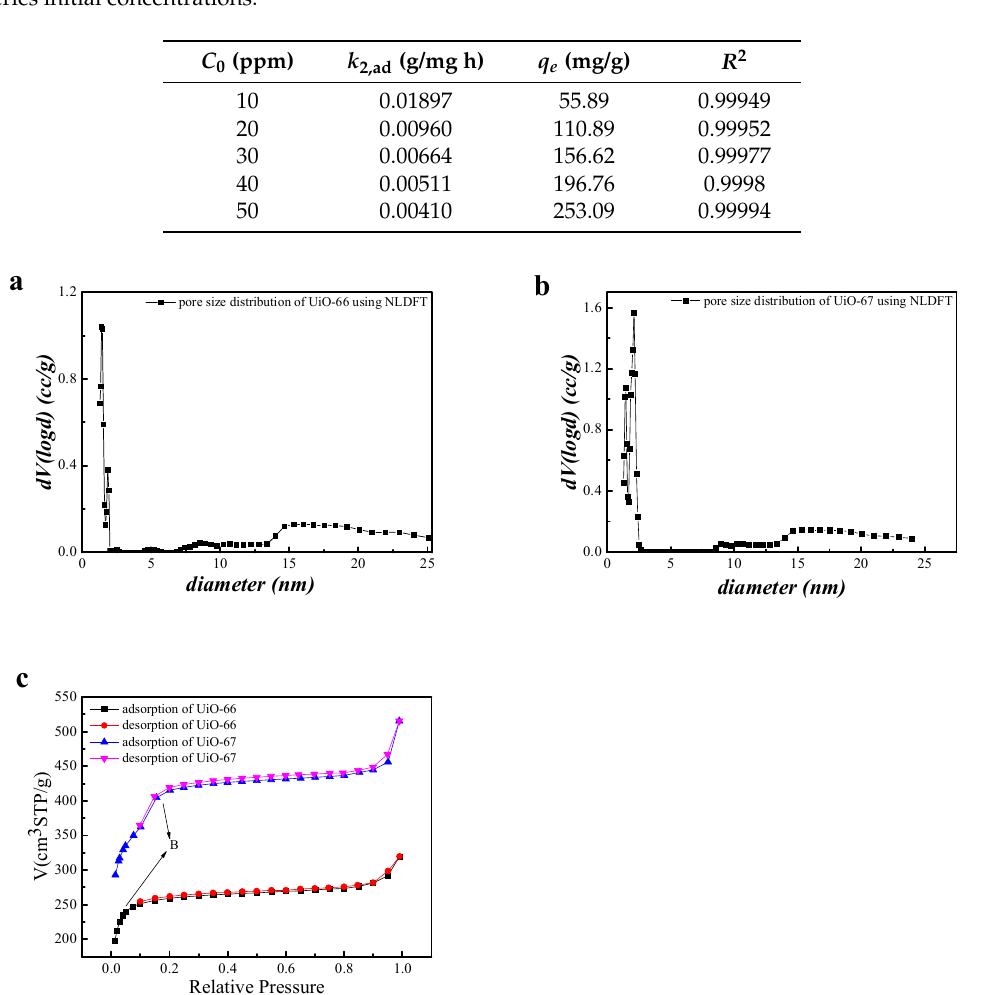
Figure 5. Pore size distribution desorption of ( a ) UiO-66, ( b ) UiO-67, and ( c ) isothermal N 2 adsorption of UiO-66 and UiO-67.